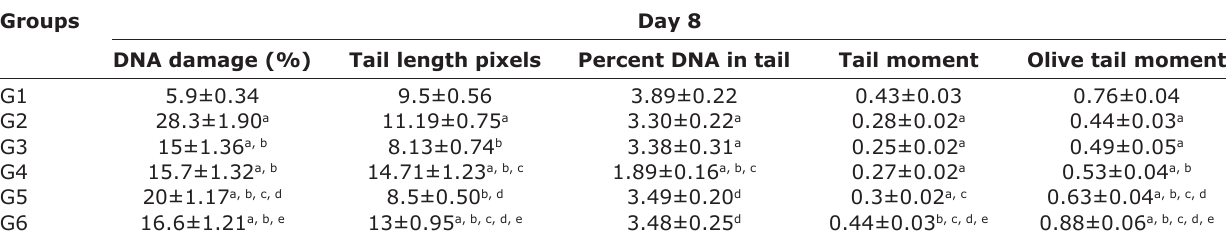
Table-1: Effect of single and repeated intravenous injection of 300 µg/kg body weight of either 50nm gold nanosphere or gold nanorods in male rabbits on comet test parameters on day 8 post-treatment. Results are reported as Mean±SD (n=5).